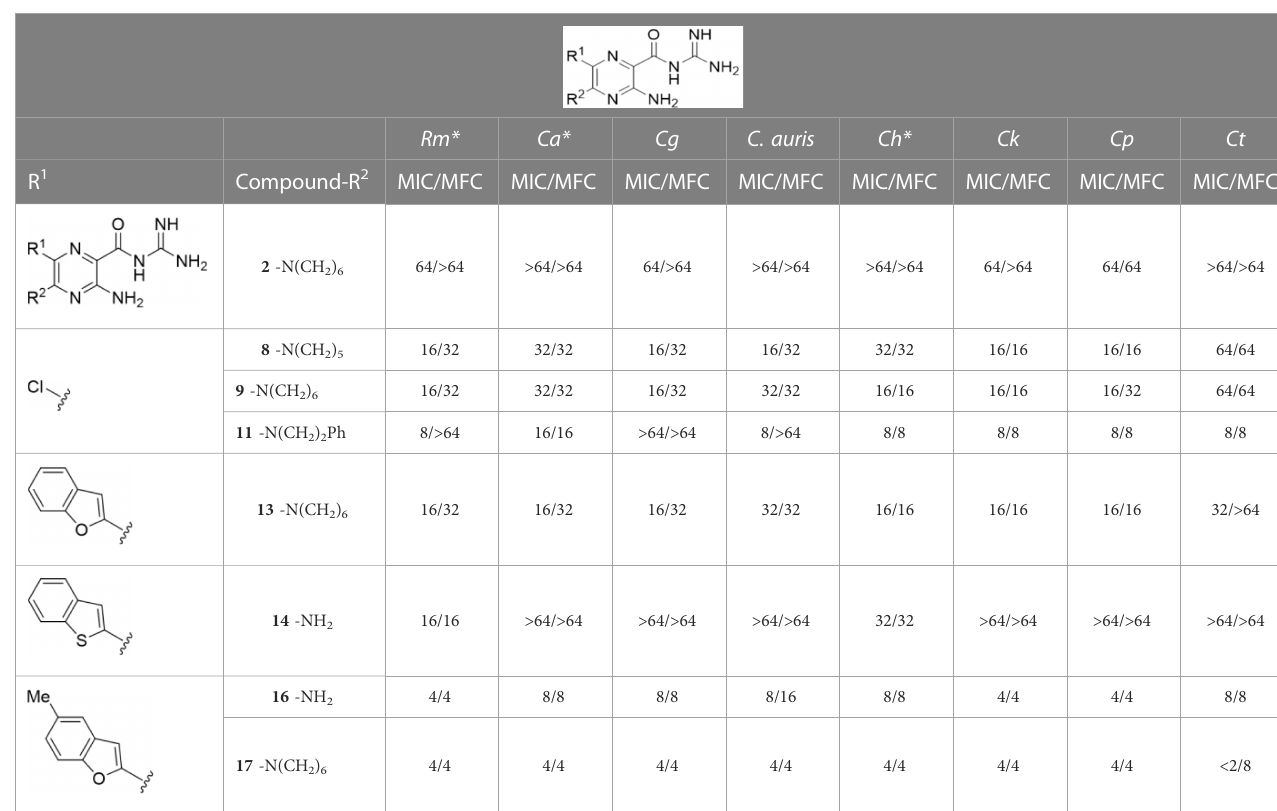
TABLE 2 Antifungal activity of amiloride and HMA analogs against Candida and Rhodotorula